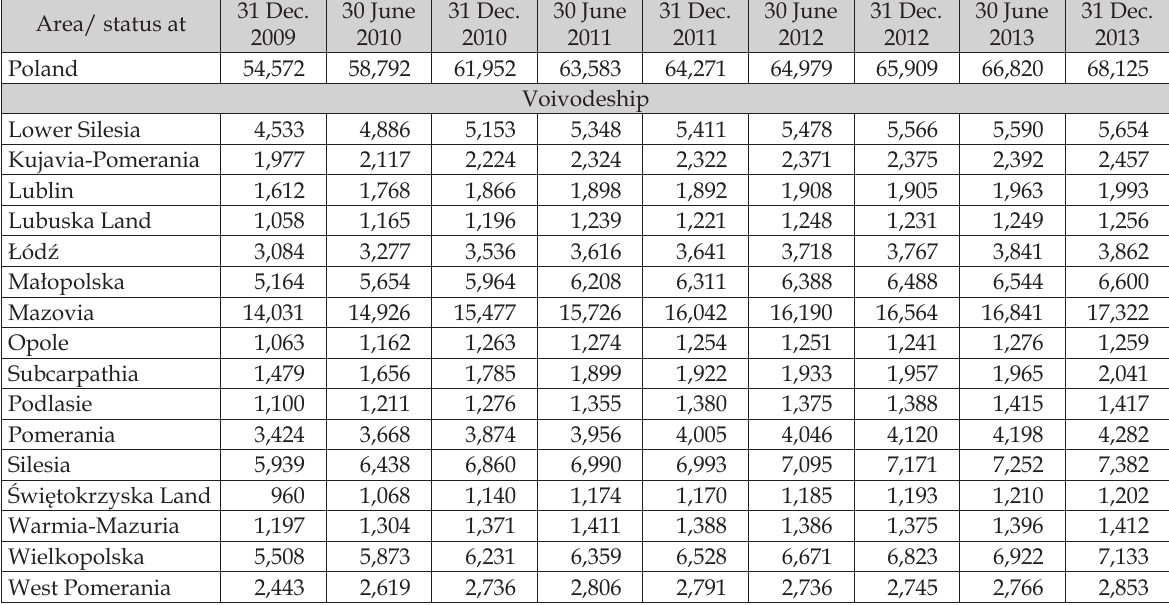
Table 6. Number of entities of the sub-sector of creative services within the creative sector entered into the REGON register in the years